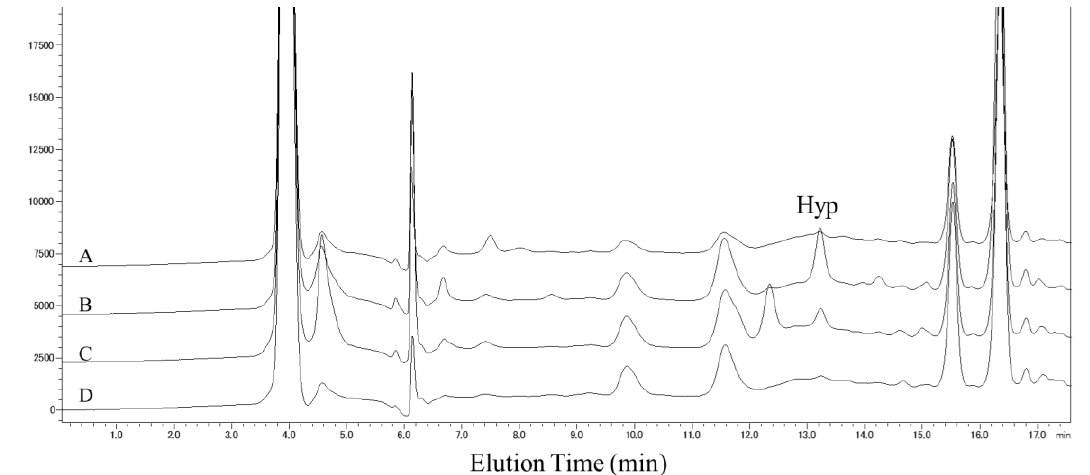
Figure 4. Amino acid analysis of the cyclic peptide fraction of mixed plasma samples from five volunteers. Cyclic peptide fractions prepared before (A) and at 1 (B), 2 (C), and 4 h (D) after ingestion of collagen hydrolysate were resolved by HPLC. Hydroxyproline peaks (Hyp) were observed in chromatograms of samples.